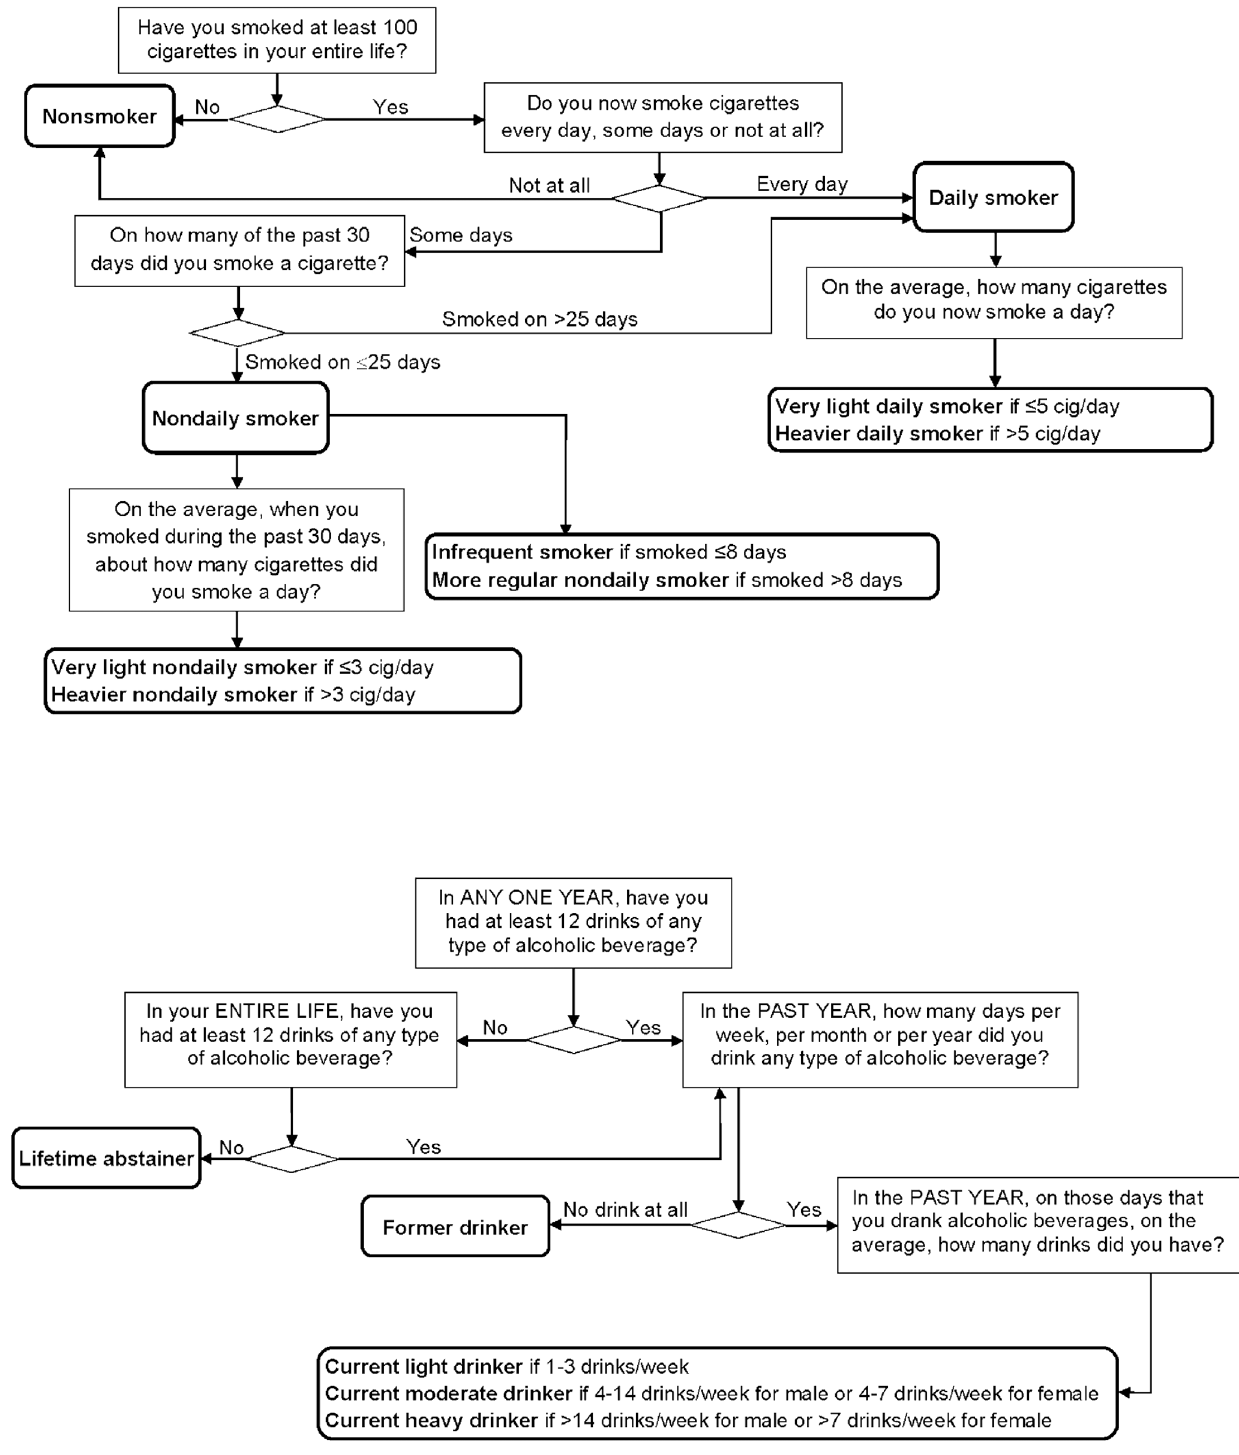
Fig 1. Classification of respondents. (a) Classification of smoking status. (b) Classification of alcohol drinking status.